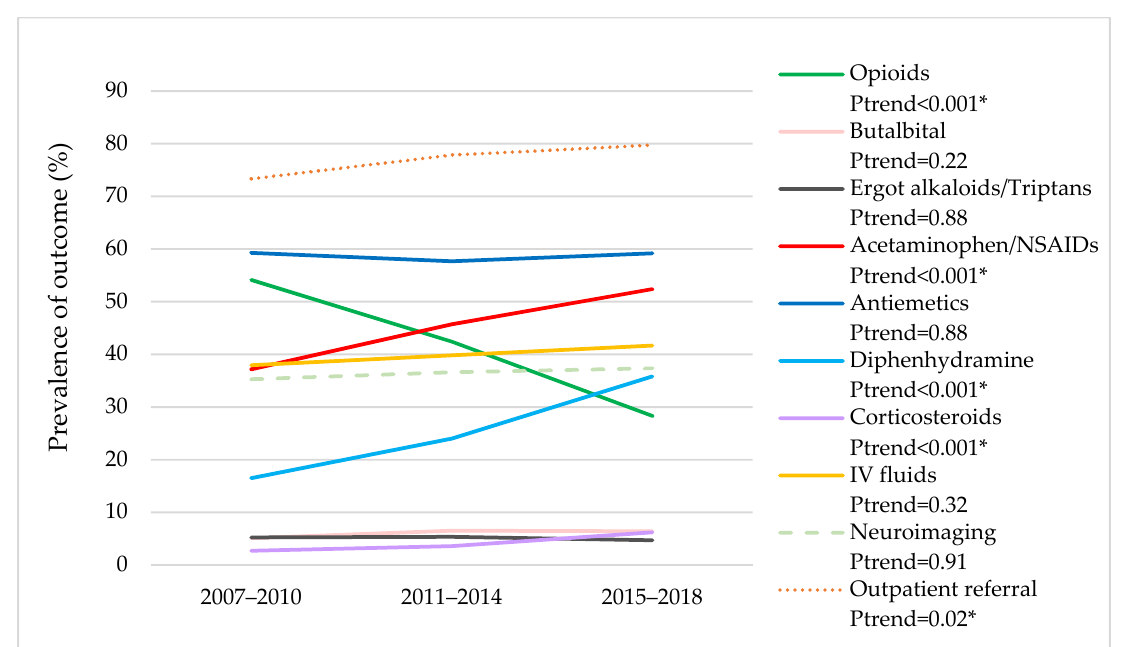
Figure 1. Trends in medication use, neuroimaging use, and referrals to follow-up among headache- related ED visits: 2007 to 2018 NHAMCS data. Abbreviations: ED: Emergency Department; NHAMCS: National Hospital Ambulatory Medical Care Survey; NSAIDs: nonsteroidal anti-inflam- matory drugs; IV: intravenous. * A statistically significant trend with P trend < 0.001. All P trend were adjusted for age, sex, race, payment source, and practice region.